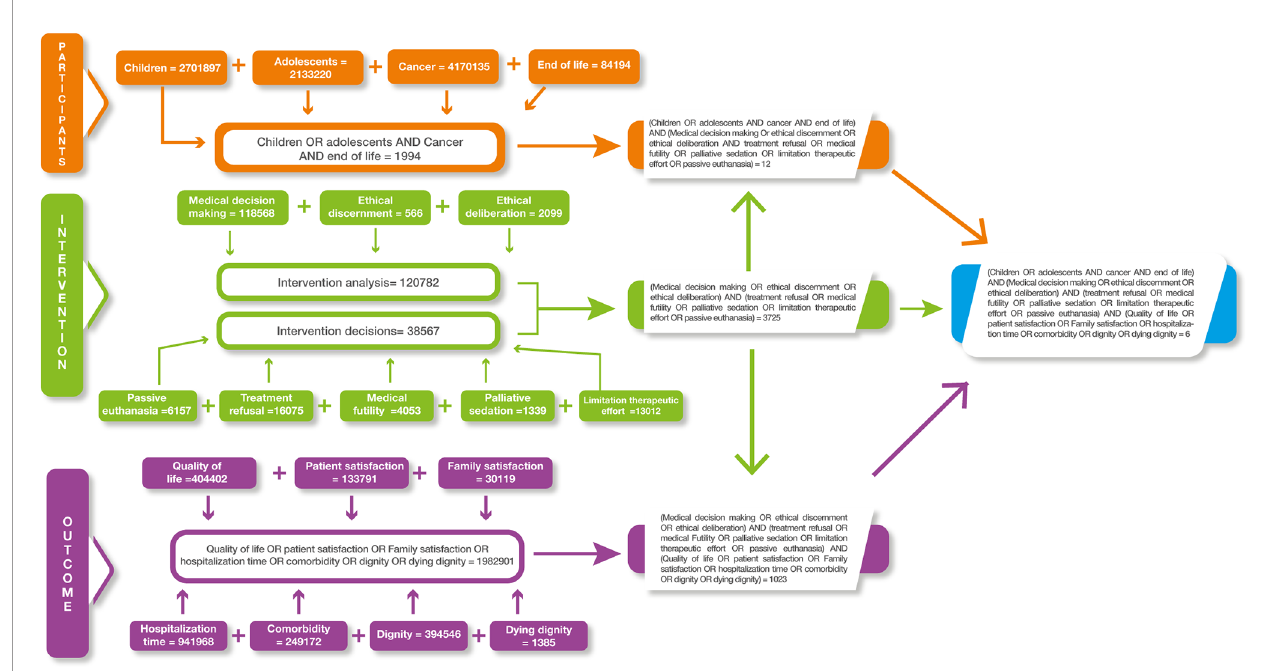
FIGURE 1 | Decision tree used for search in databases. Example of the PUBMED database